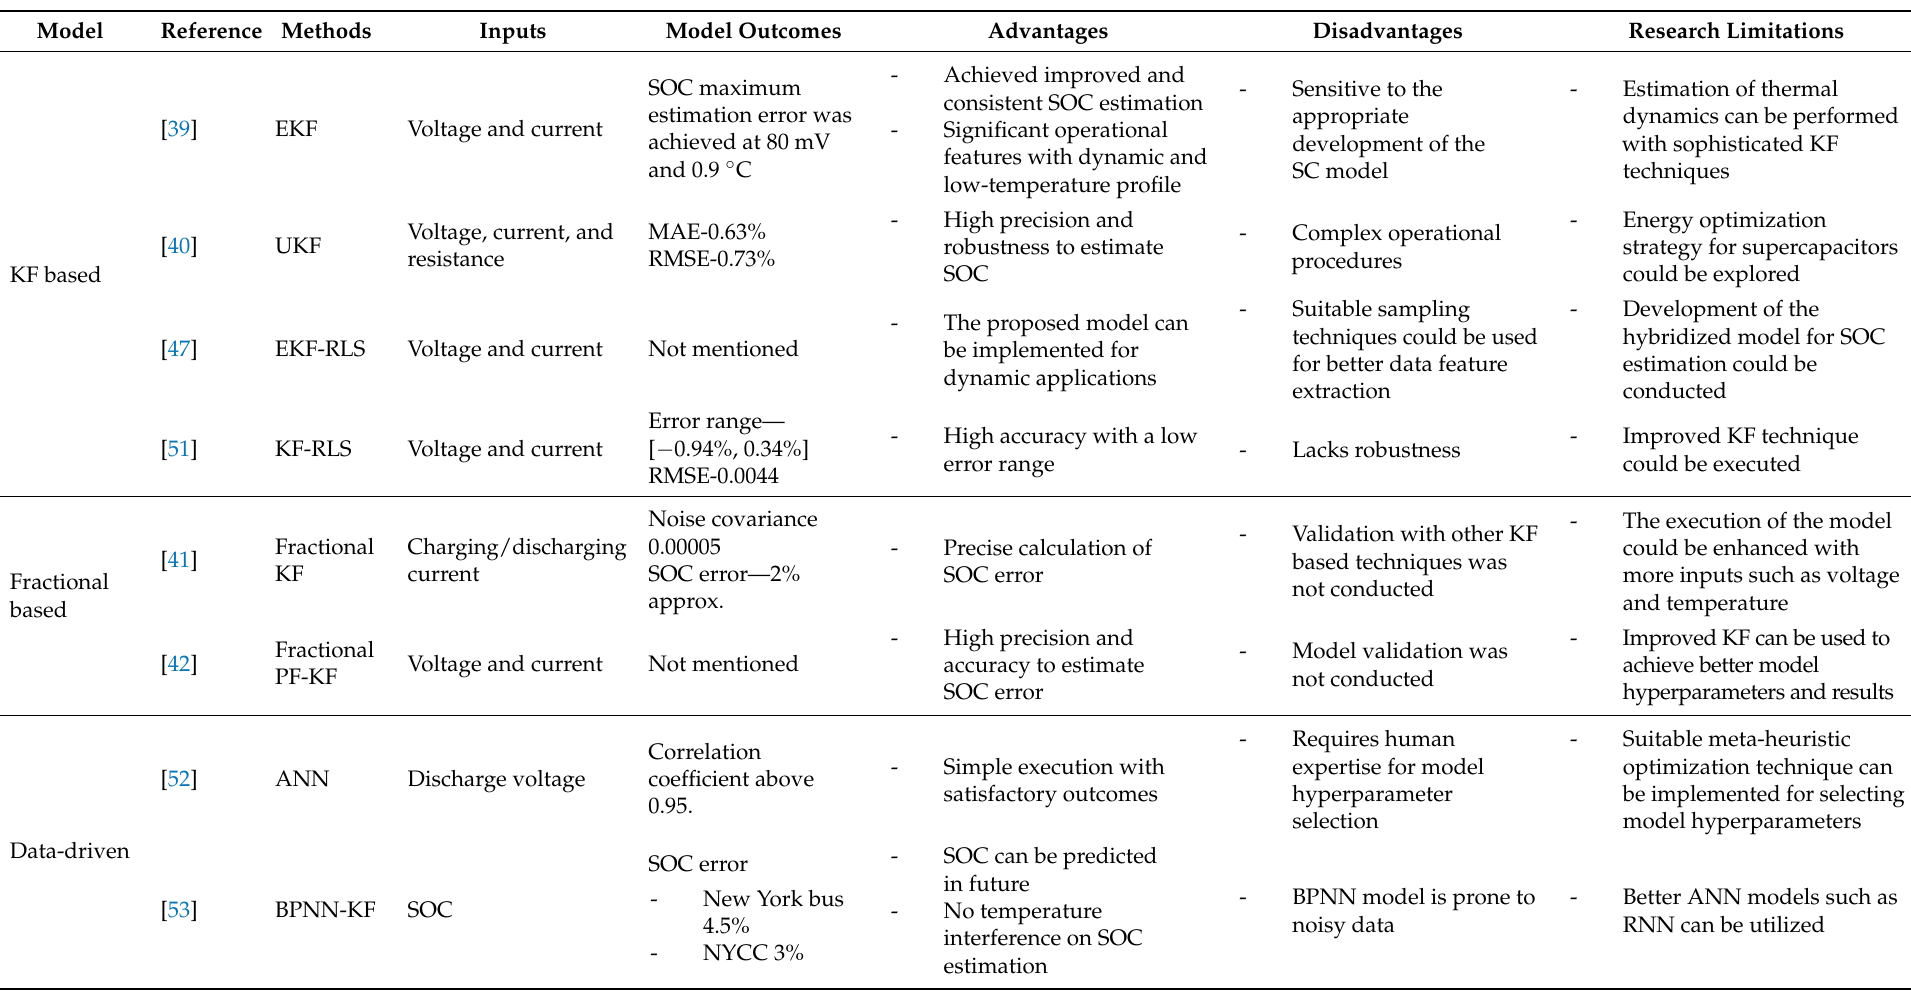
Table 1. Comparative analysis of model-based and data-driven methods for SOC estimation of